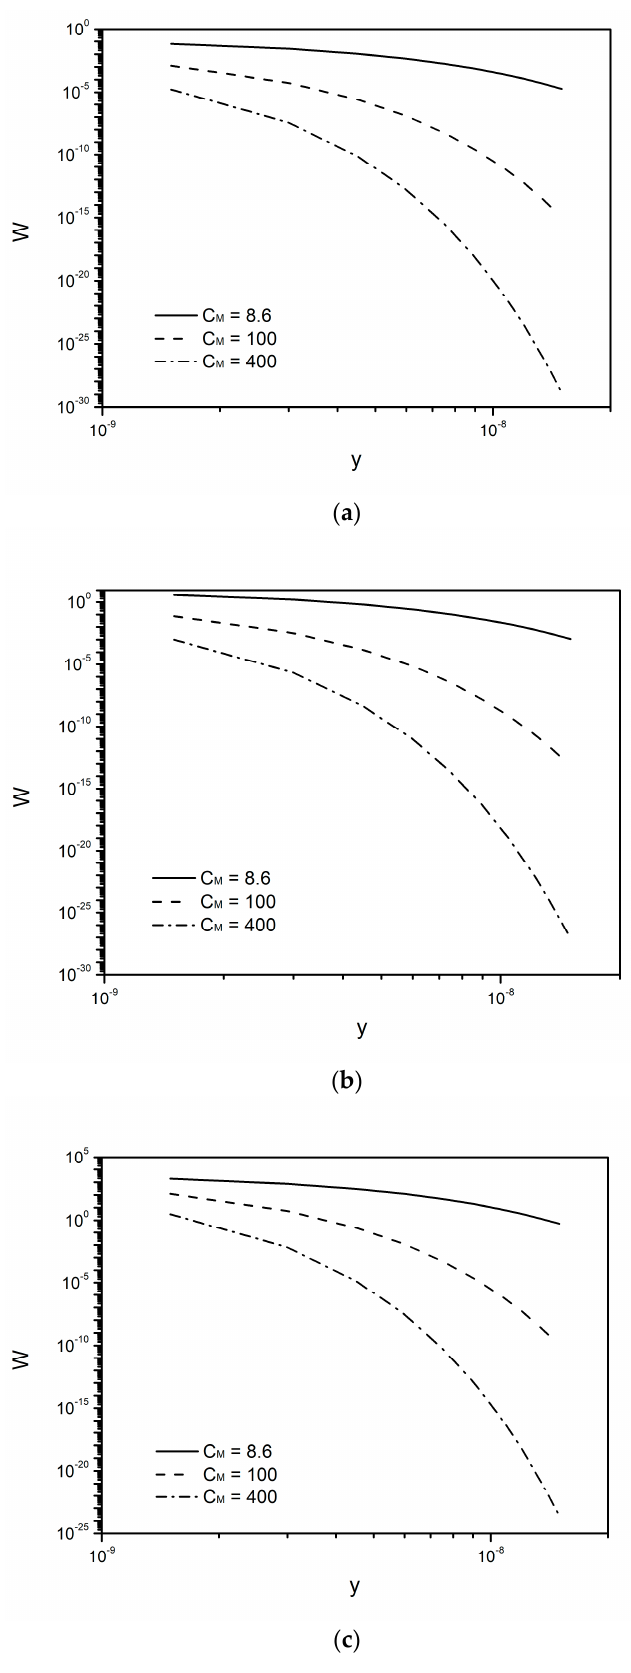
Figure 6. Effect of the nonlinearity on W at ϕ ( 0 ) = 0.026 ( a ) , 0.2 ( b ) and 2 ( c ) along y for various C M